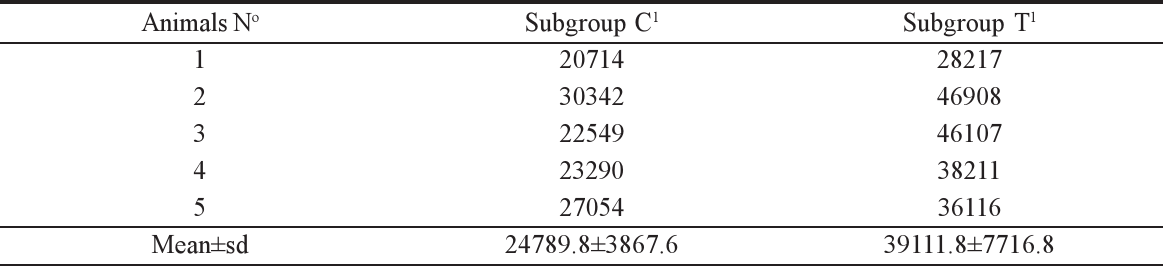
TABLE 1 - Distribution of histopathologic density of inflammatory elements in the subgroups observed for five days.